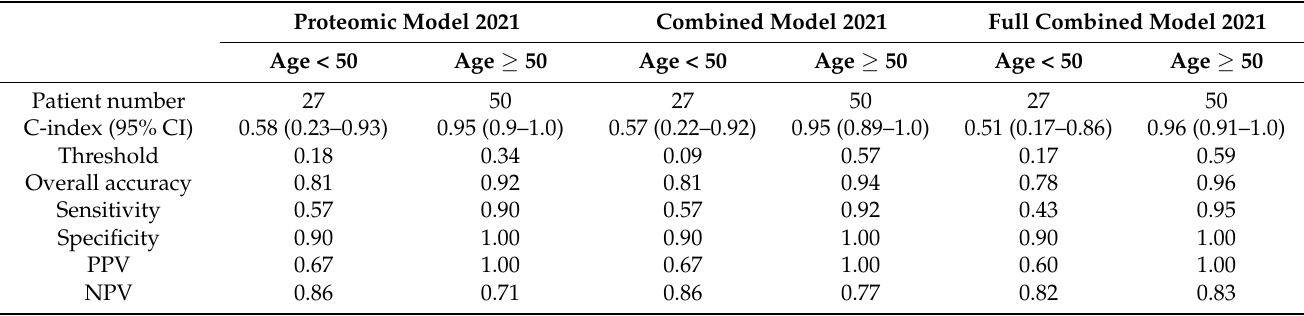
Table 3. Measures of diagnostic accuracy broken down by age (cutoff 50